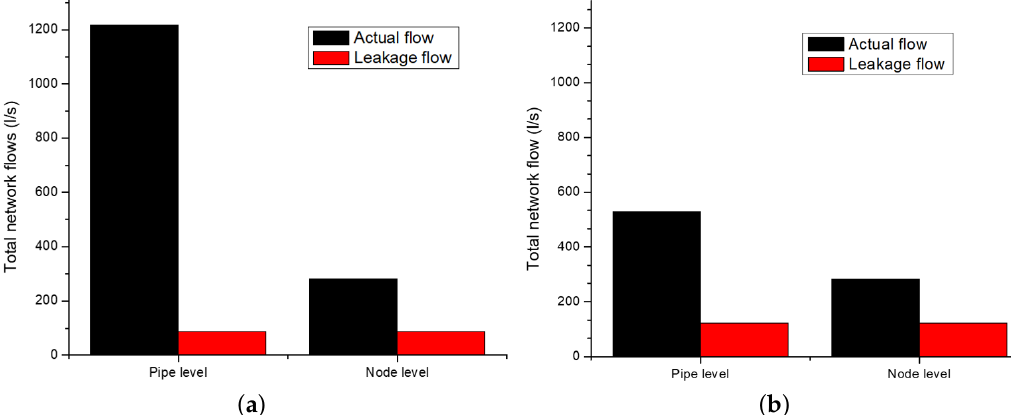
Figure 7. Total network leakage flow with respect to the nodal demands and pipe discharges for the case study network 2: ( a ) DDM analysis; ( b ) PDM analysis.